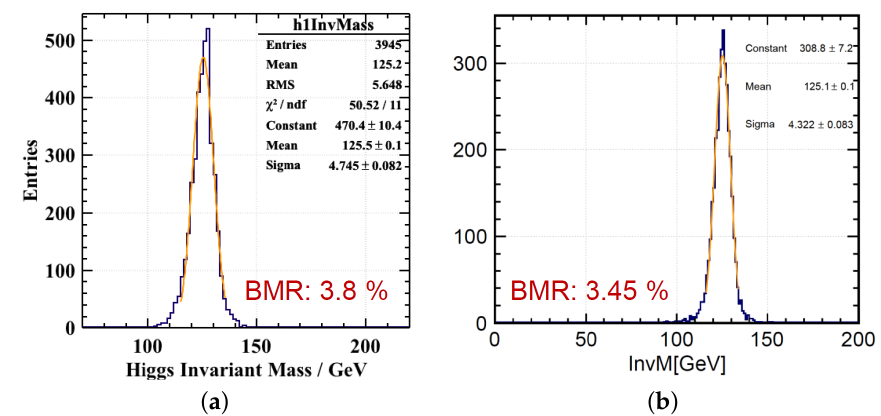
Figure 6. BMR of ZH → νν gg at 240 GeV with a low energy threshold around 2.5% MIP. ( a ) CEPC CDR baseline detector; ( b ) CEPC CDR baseline detector with the baseline SiW ECAL and the HCAL replaced by a homogeneous HCAL, which is 40 layers of 40 × 40 × 40 mm 3 glass tiles (included with readout PCB and without any absorber). It needs to be noted that this setup configuration is not meant to be the final HCAL design, nor to meet the CEPC CDR requirement, but only to illustrate the physics potentials with the sufficient depth in the HCAL. Ongoing studies are being carried out with the exact same depth as the CDR requirement of around 4.8 λ I as the total